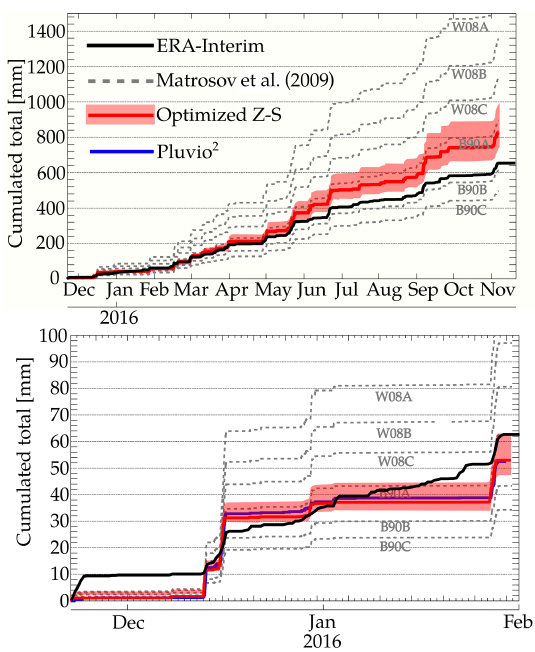
Figure 9. Time series of accumulated snowfall liquid water equiva- lent. The relations are obtained from Pluvio 2 (in blue, for availabil- ity periods), censored from phantom precipitation, MRR (in grey the curves corresponding to the relations of Table 2, and ERA- Interim data (in black). Top panel: data corresponding to the year of measurements from November 2015 to November 2016. Bottom panel: data corresponding to the summer campaign 2015/2016